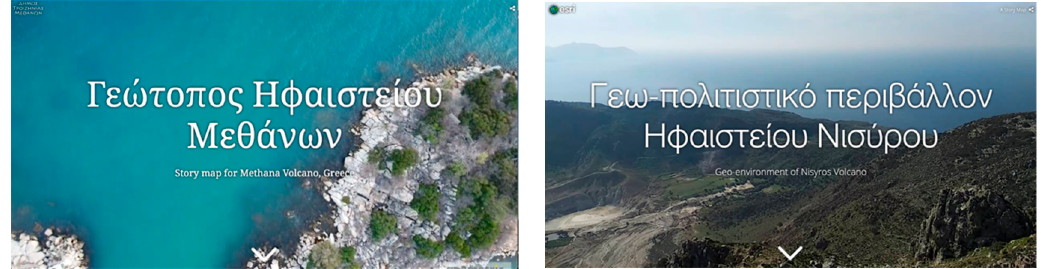
Figure 5. Story Maps for Troizinia–Methana (https://tinyurl.com/y3w6k7mb) and Nisyros (https://tinyurl.com/vstjq36) Volcano Municipality.